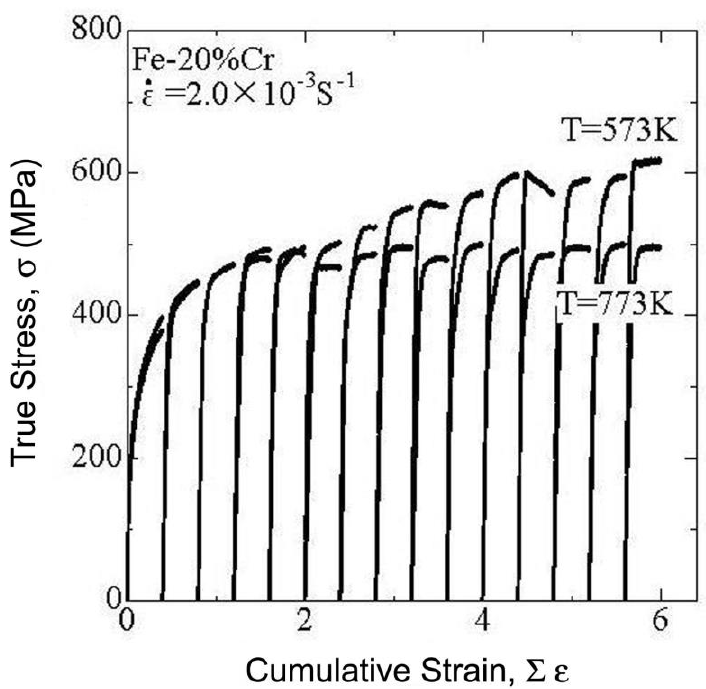
Figure 2. Two sets of interrupted stress–strain curves obtained during multiple forging of a Fe-20%Cr steel at 573 K or 773 K. Reproduced from [60], with permission from Springer Nature, 2023.